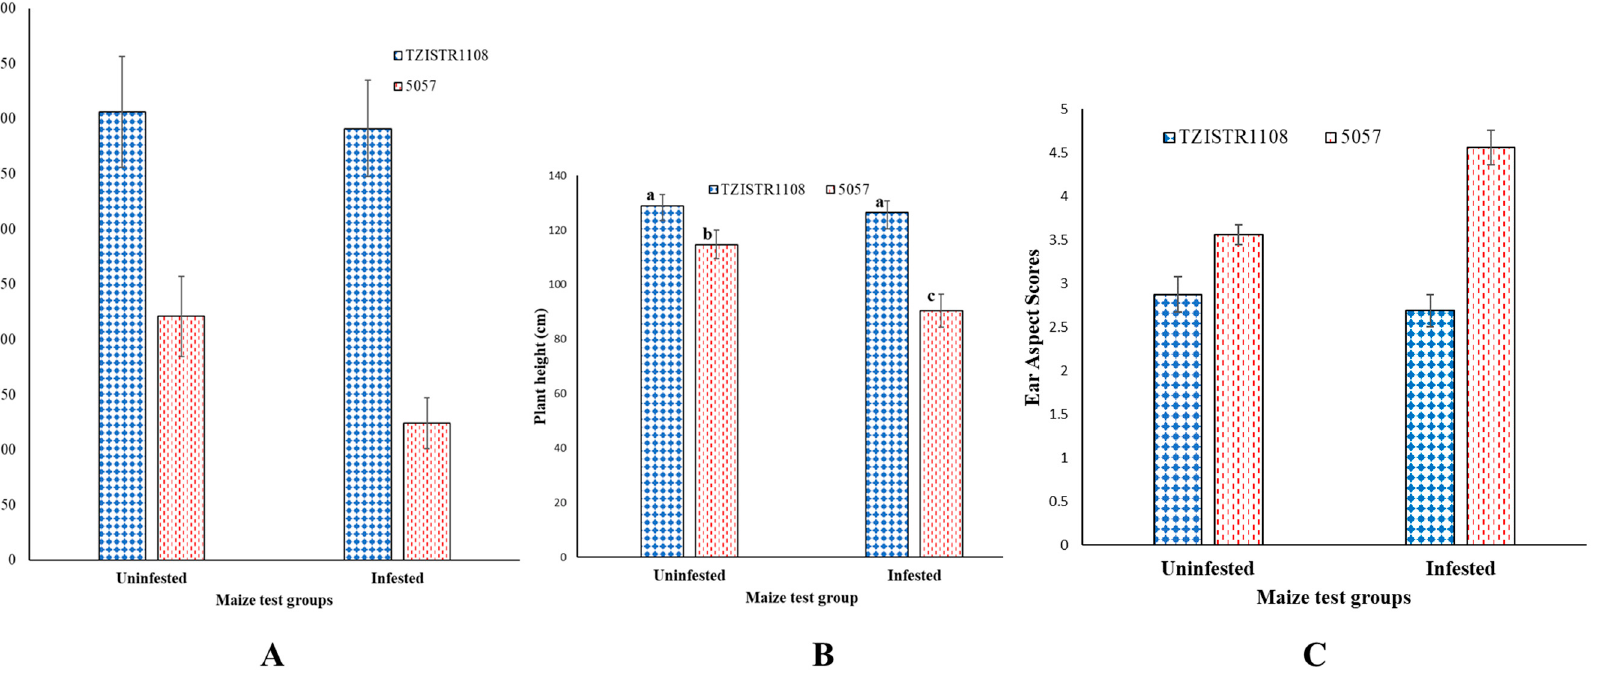
Figure 10. Field estimates of grain yield and two associated traits upon infestation and without infestation. ( A ) Mean grain yield of both lines. ( B ) Mean plant height of both lines. ( C ) Mean ear aspect scores of both lines. The different letters (a, b and c) show significant differences among the groups ( α = 0.05). The bars show standard error.